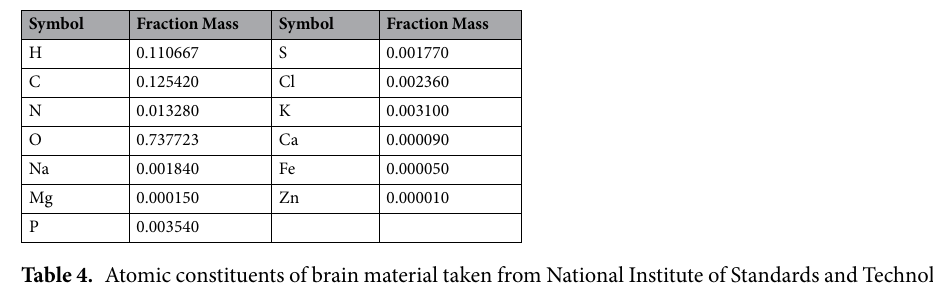
Table 4. Atomic constituents of brain material taken from National Institute of Standards and Technology (NIST) Listings, “Compositions of Materials used in STAR Databases” webpage. source by: http://physics.nist. gov/cgi-bin/Star/compos.pl?matno =